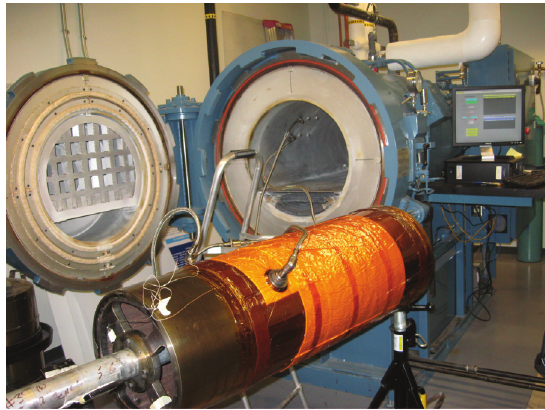
Figure 5: Autoclave treatment of the thermoplastic truncated cone made by AFP.